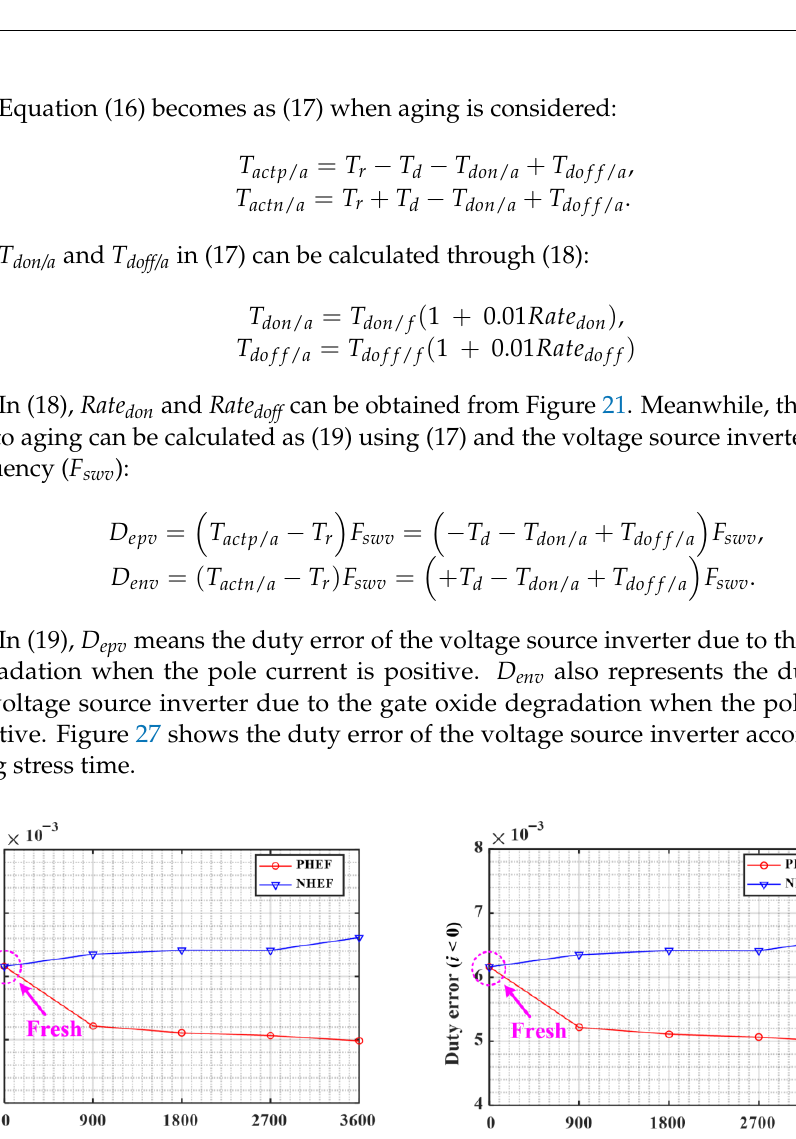
Table 4. Parameters of grid-connected voltage source inverter.